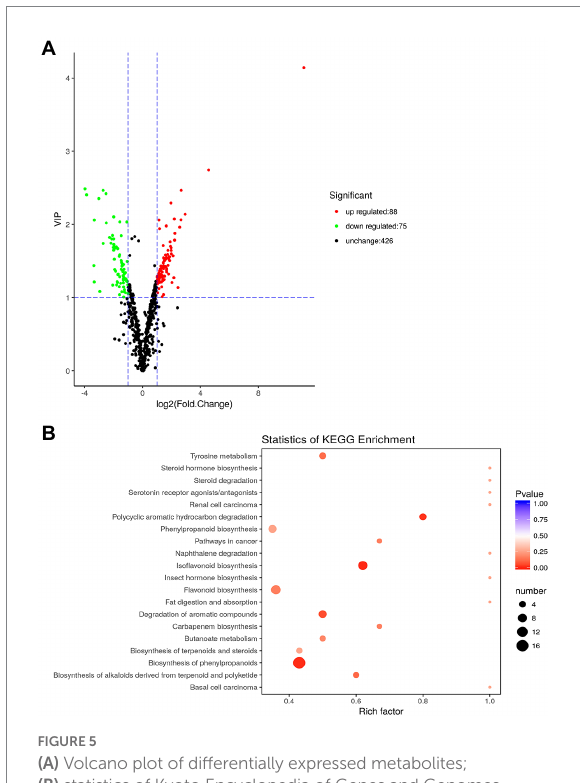
FIGURE 5 (A) Volcano plot of differentially expressed metabolites; (B) statistics of Kyoto Encyclopedia of Genes and Genomes (KEGG) enrichment. Leaves of plants under AC + AT and EC + HW conditions.